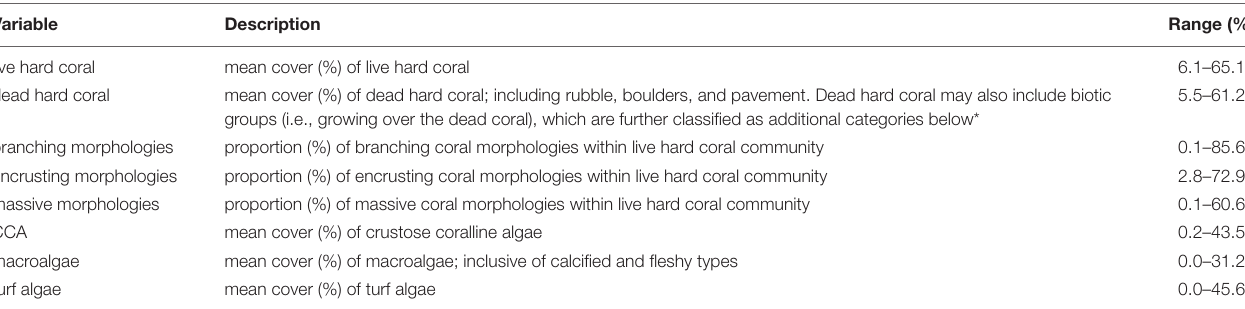
TABLE 1 | Benthic variables included in the models and their